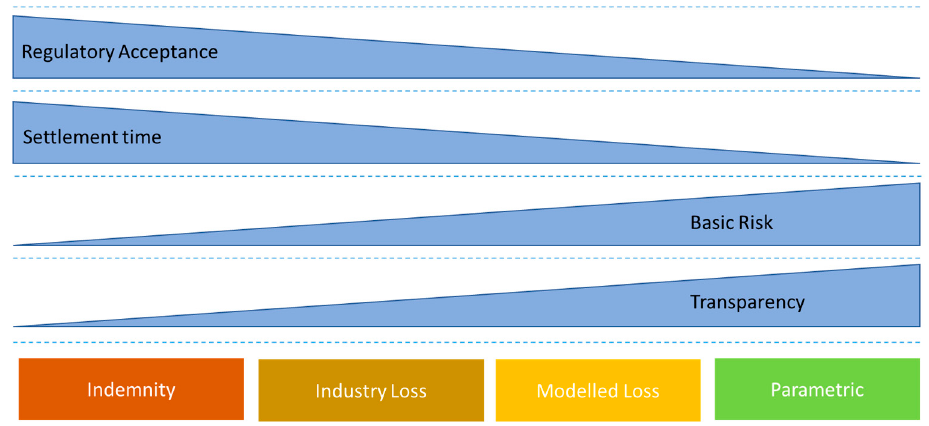
Figure 4. Comparison of disaster bond trigger types; source: adapted from Braun and Kousky (2021) [60].